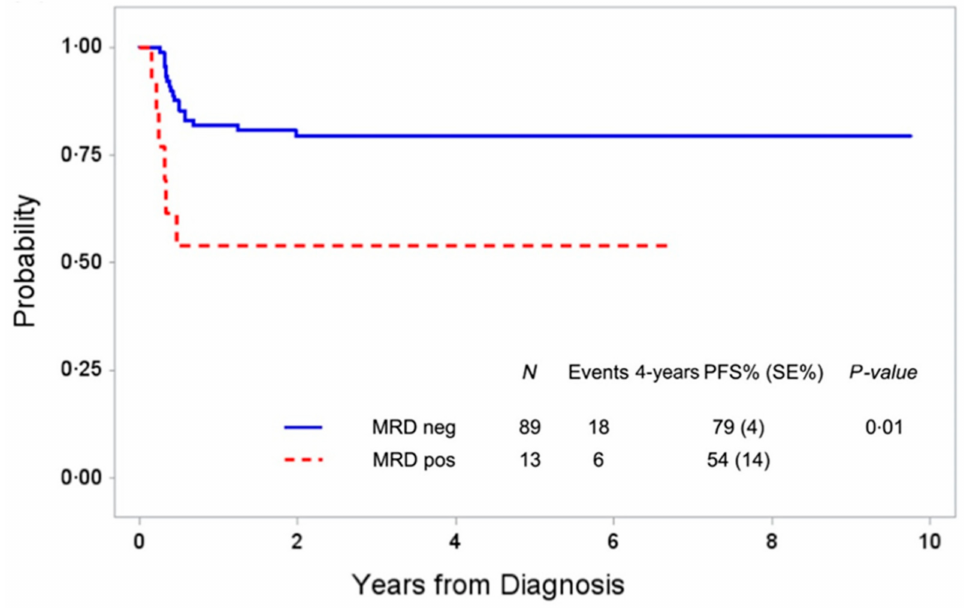
Figure 1. Four-year progression-free survival (PFS) of 102 children with Burkitt leukemia or stage IV Burkitt lymphoma according to minimal residual disease before the second course of Berlin- Frankfurt-Muenster (BFM)-type chemotherapy as measured by long-distance PCR for MYC-IGH or patient-specific IG rearrangements (from Mussolin et al.